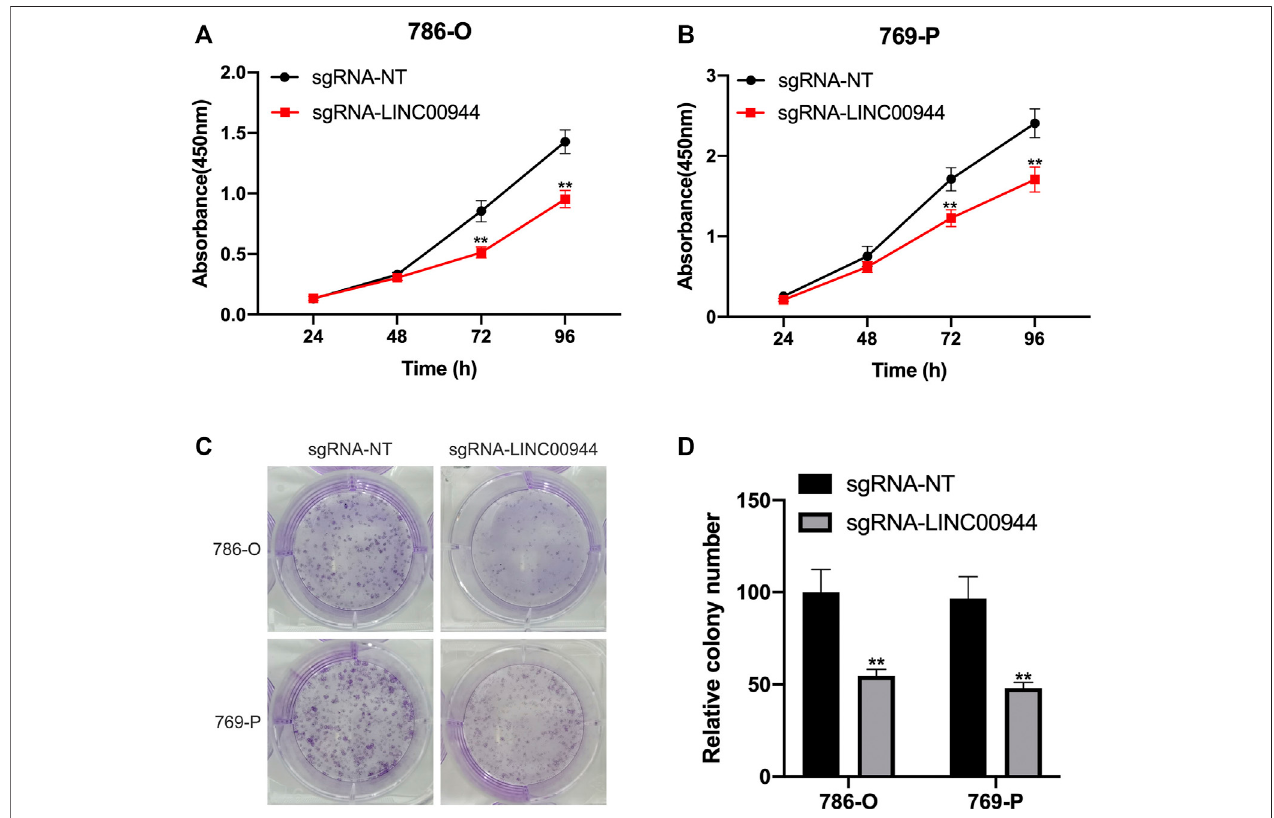
FIGURE 3 | Downregulation of LINC00944 inhibited the proliferation of RCC cells. (A,B) CCK-8 assays of 786-O and 769-P RCC cells transfected with dCas9-KRAB and sgRNAs. (C,D) Colony formation assays of 786-O and 769-P RCC cells transfected with dCas9-KRAB and sgRNAs. ** p < 0.01.